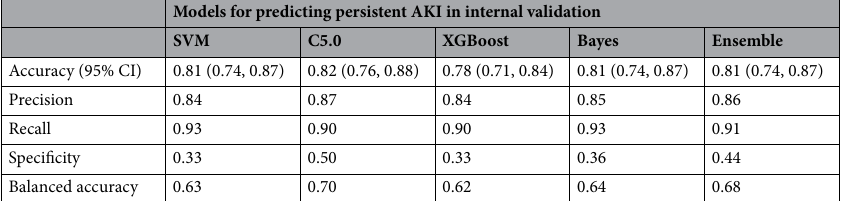
Models for predicting persistent AKI in internal